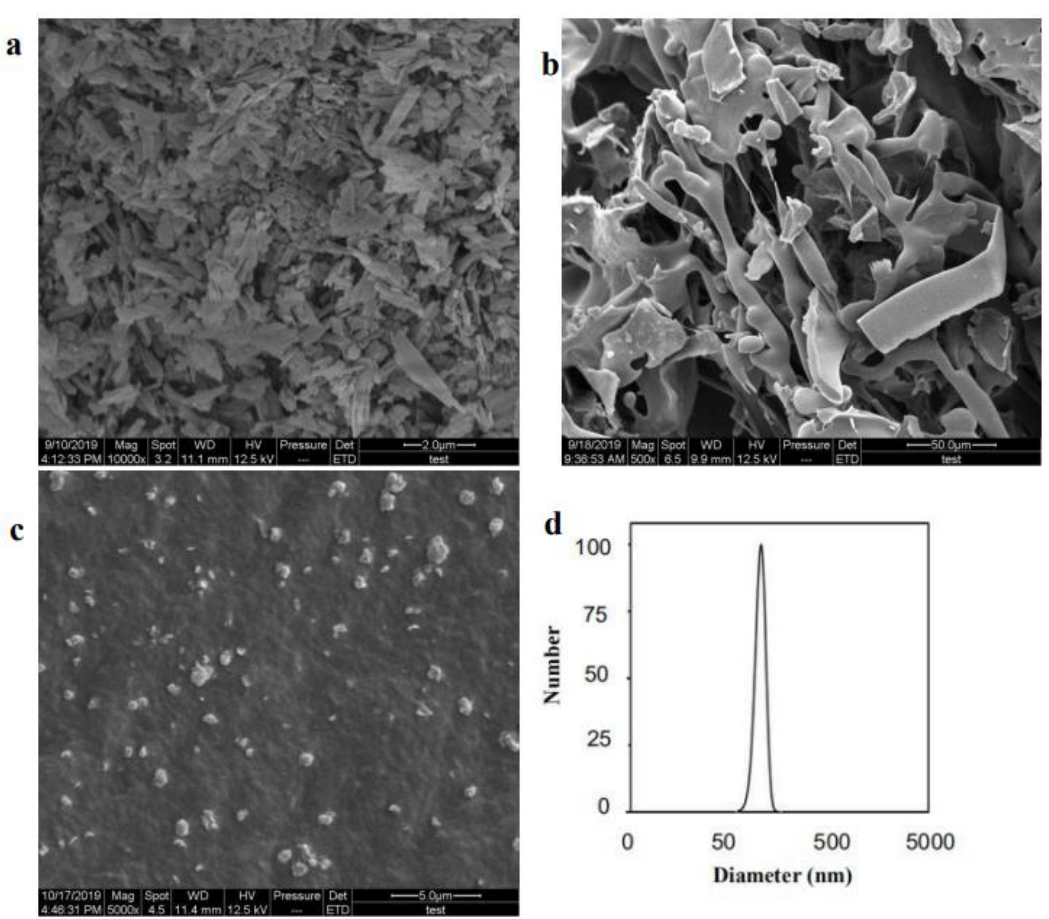
Figure 4. Images of samples detected by SEM. ( a ) Raw API, ( b ) freeze-dried API nanoparticles, ( c ) processed API nanoparticles, and ( d ) normal distribution curves of MPS of API nanosuspension.